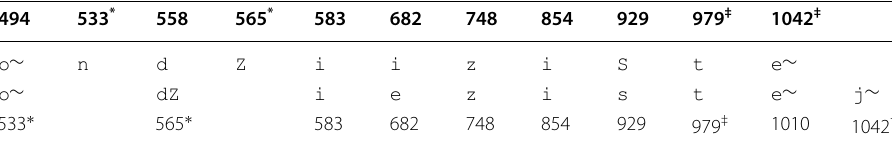
Markers depict either merging (*) or splitting (‡) of